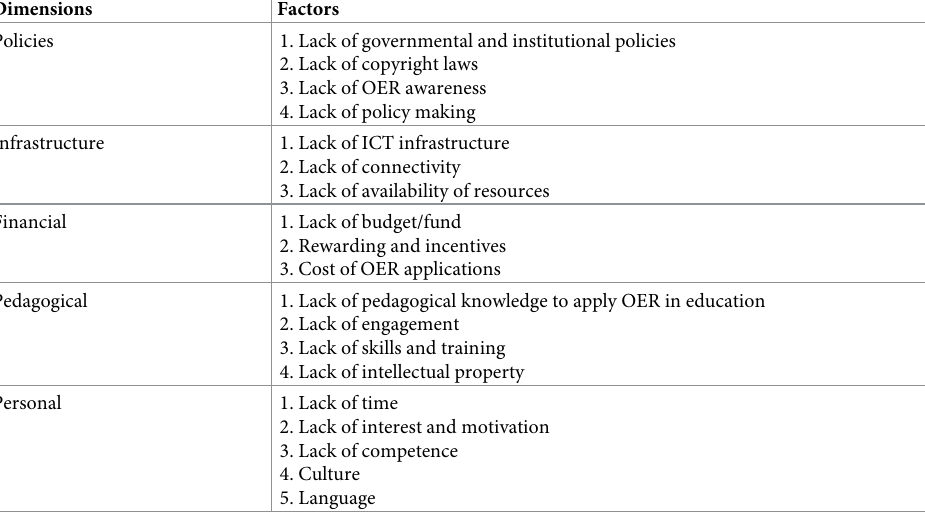
Table 5. Challenges to OER in